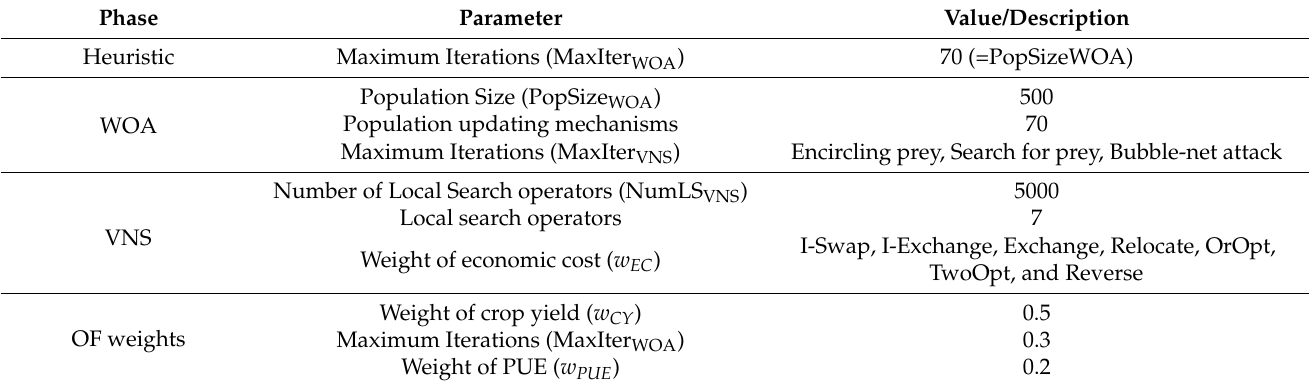
Table 6. Parameters of the H-WOA-VNS